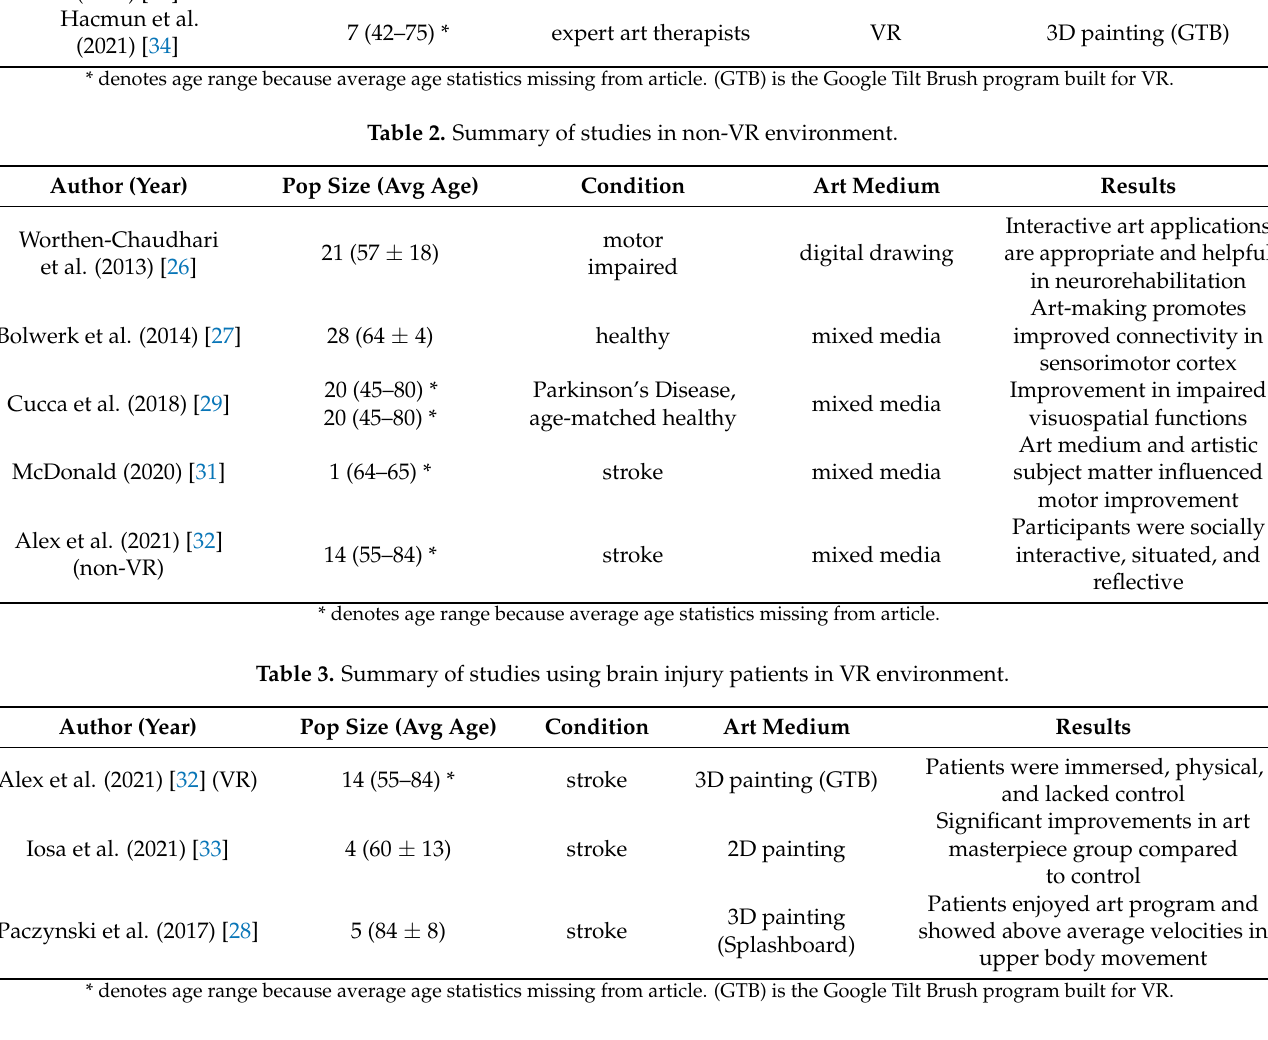
Table 4. Summary of studies using healthy participants in VR